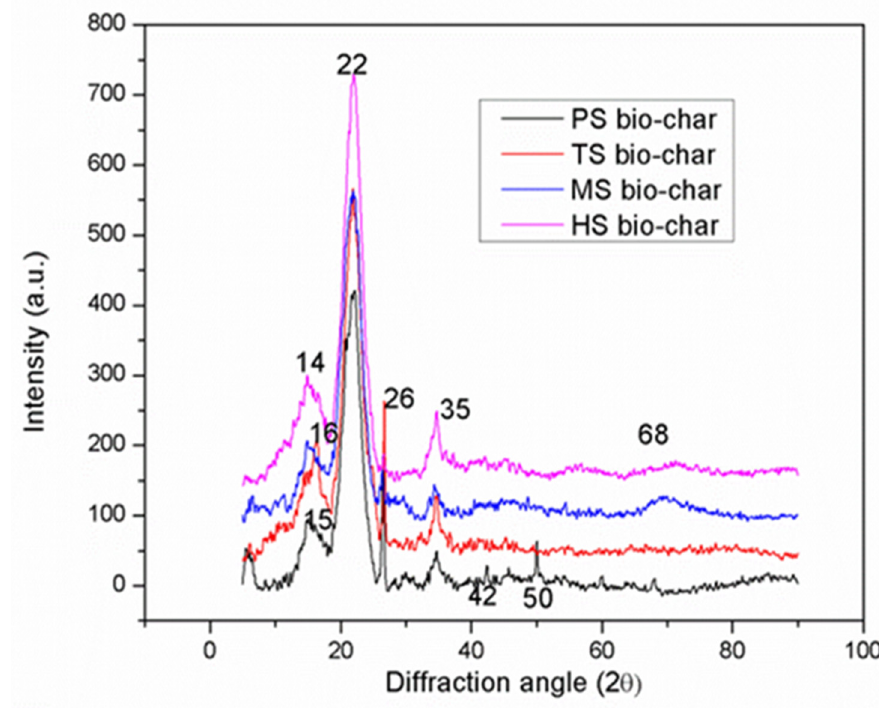
Figure 6. XRD of the different types of bio-char.